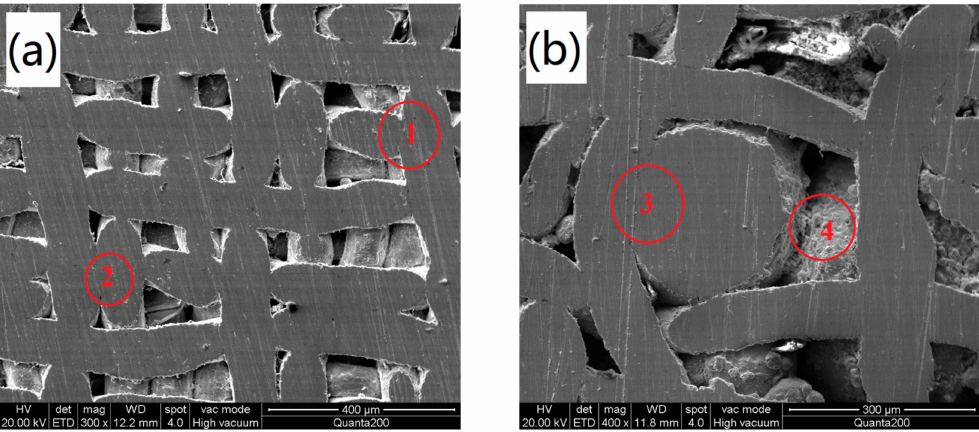
Figure 3. SEM images of the bonding types of WMPPs. ( a ) Sample made by wire mesh; and, ( b ) sample made by wire mesh and metal